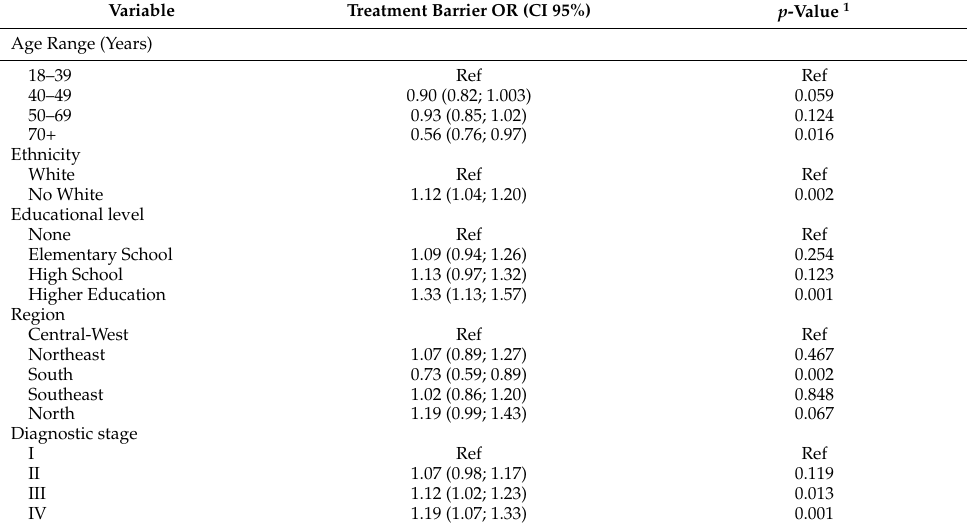
Table 2. Analysis of factors associated with barriers to initiation of treatment (treatment barrier) in women diagnosed with breast cancer. Variable Treatment Barrier OR (CI 95%) p -Value 1 Age Range (Years)